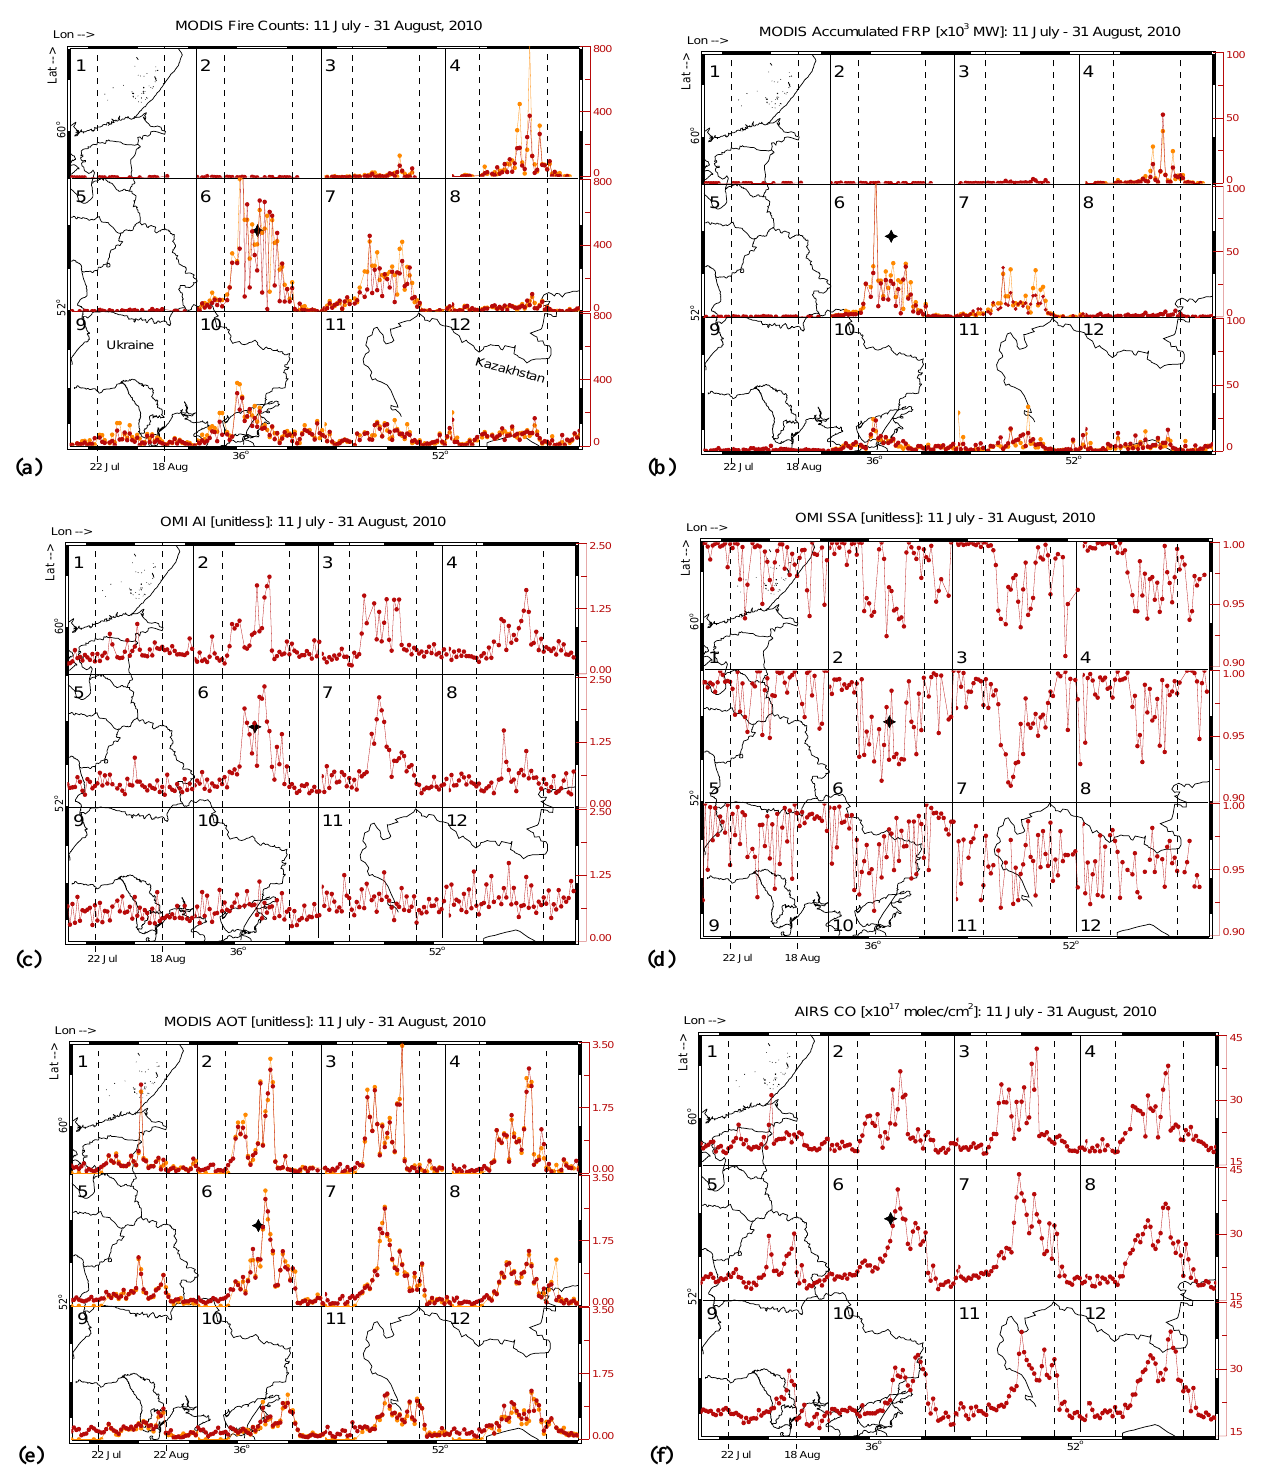
Fig. 4. Time series of fire products, smoke tracers and aerosol properties plotted within 12 geographic domains. The time period shown is from 11 July to 31 August 2010. The latitude and longitude limits of each domain are defined in Table 1. Time series of MODIS fire counts and FRP ( a and b ) are daily sums within each domain. Time series of OMI AI and SSA, MODIS AOT . 55 and AIRS CO TC (c–f) are area averages. The dashed vertical lines within each domain mark the active fire period between 22 July and 18 August. The solid black star in domain 6 indicates Moscow. In (a) , (b) , and (e) Aqua-MODIS data are red, and Terra-MODIS in